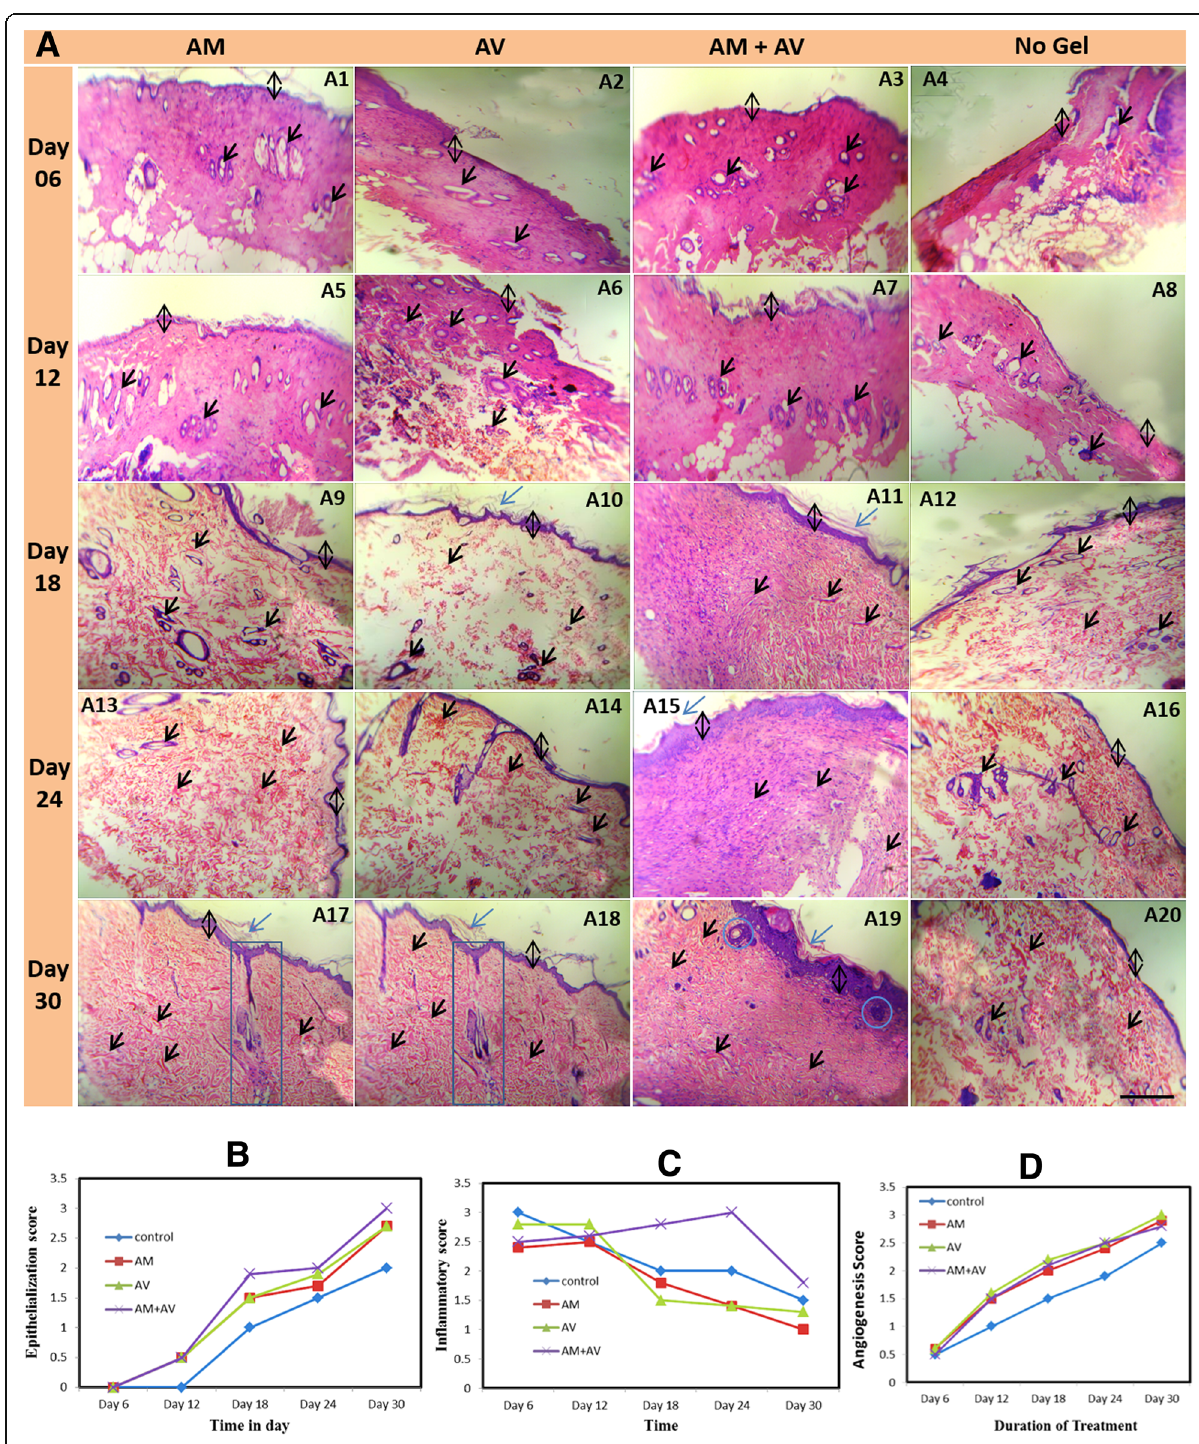
Fig. 6 Haematoxylin and Eosin (H&E) staining of skin at different time points during the gel-based treatment ( a ). Stained images (100x magnification) were shown for all four groups (AM, AV, AM+AV, and non-treated control) at day 6 (a1-a4), 12 (a5-a8), 18 (a9-a12), 24 (a13-a16) and 30 (a17-a20). Re-epithelialization ( b ), inflammatory ( c ), and angiogenesis ( d ) scoring from the images represents a qualitative and quantitative assessment of healing. Black double headed arrow represents the thickness of epidermis; single headed blue arrow shows the keratinized zone of skin, single headed black arrow projects the blood vessel, formation of new glands beneath the epidermis is shown in blue box (a17, a18), and inside the blue round box (a19) some basal keratinocytes were